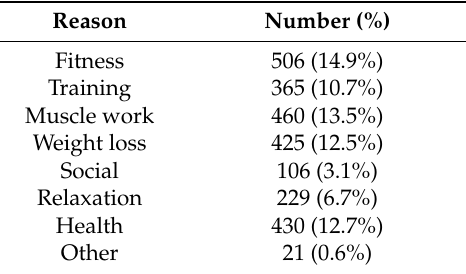
Table 5. Reasons ‡ for gym use (N =